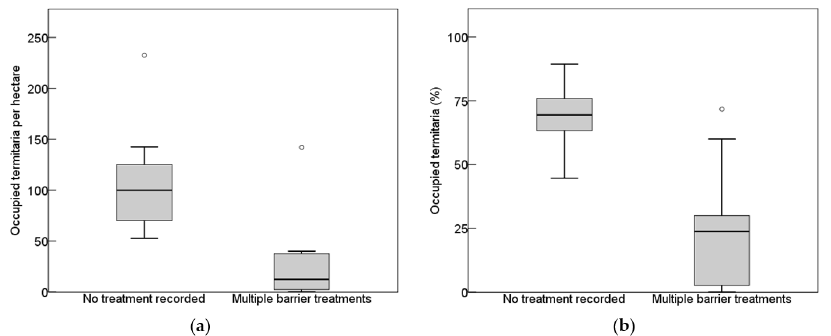
Figure 2. Boxplots of the density ( a ) and percentage ( b ) of occupied termitaria in unsprayed (no treatment recorded) and repeatedly sprayed (multiple barrier treatments) areas ( N = 9 in both treatments). Box plots show the median, lower/upper quartile, and smallest/largest observation and outliers ( ◦ ). Differences among sprayed and unsprayed areas are statistically significant (see